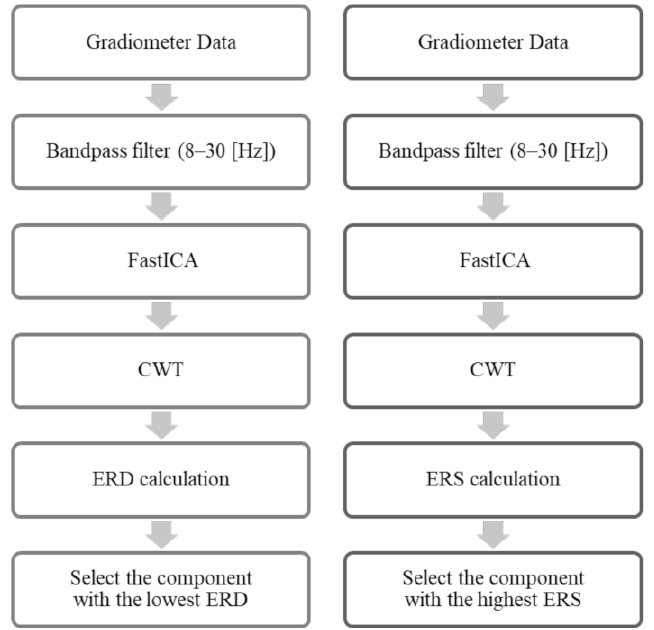
Figure 2. The FastICA analysis flow. Total number of components was 10 or